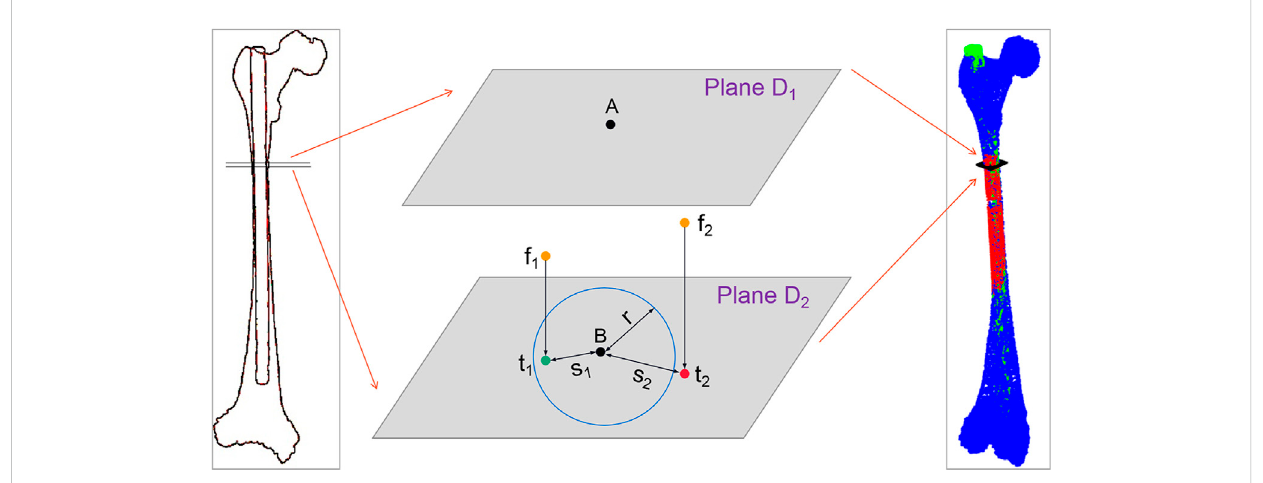
FIGURE 3 Schematicdiagramofoutside-pointscalculation.Where f 1 and f 2 arethetwopointsinthepointset P middle ,and t 1 and t 2 aretheirprojectionpoints. s 1 and s 2 are the distances from the two projection points to control point B , and the blue circle represents the fi tting circle of the medullary cavity cross- section at control point